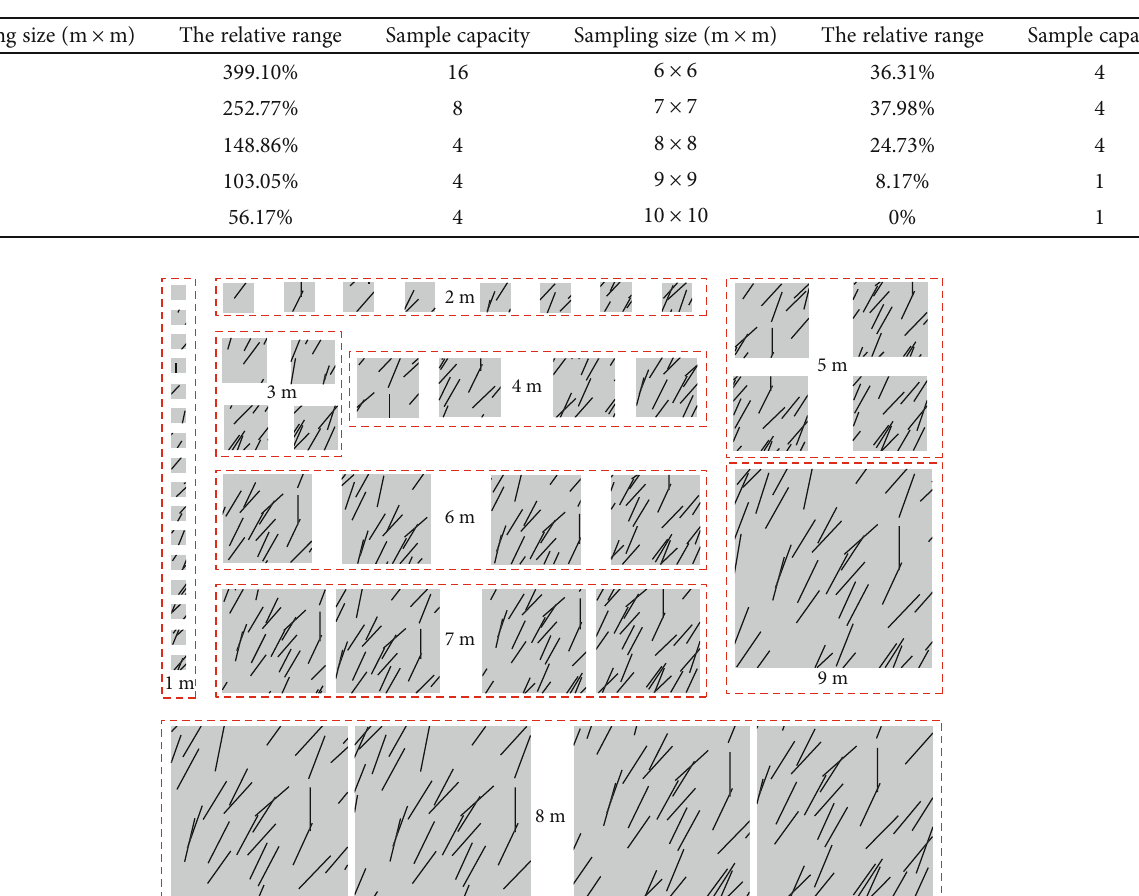
Table 3: Information statistics of layered sampling with di ff erent sampling sizes.